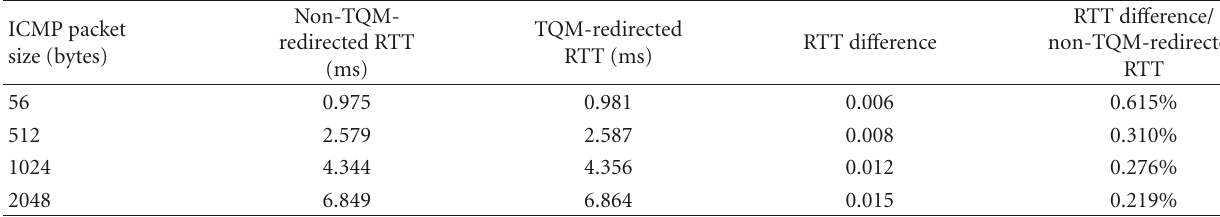
Table 1: Flow redirection overhead.